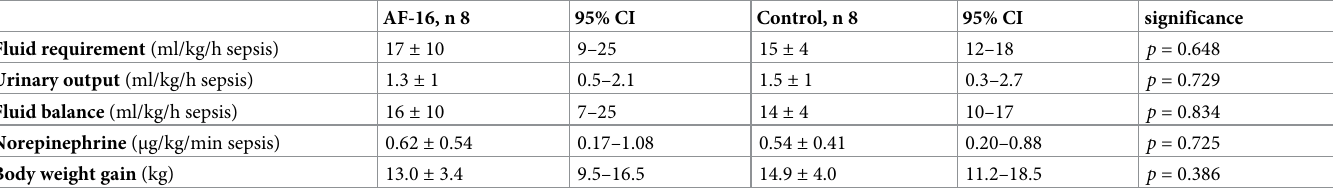
Table 4. Fluid balance.